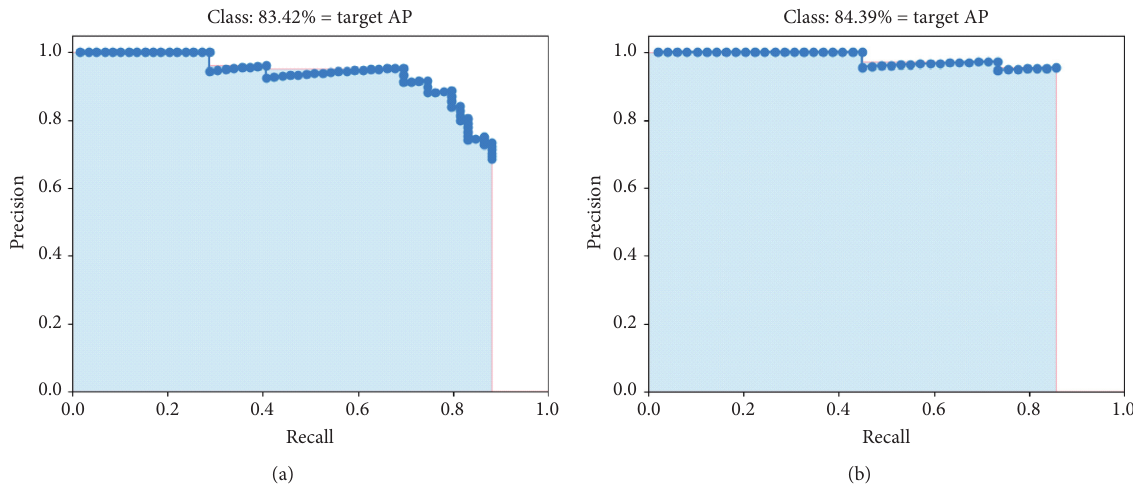
Figure 7: The P-R curves of the two models: (a) original model and (b) yolov3 model based on transfer learning.